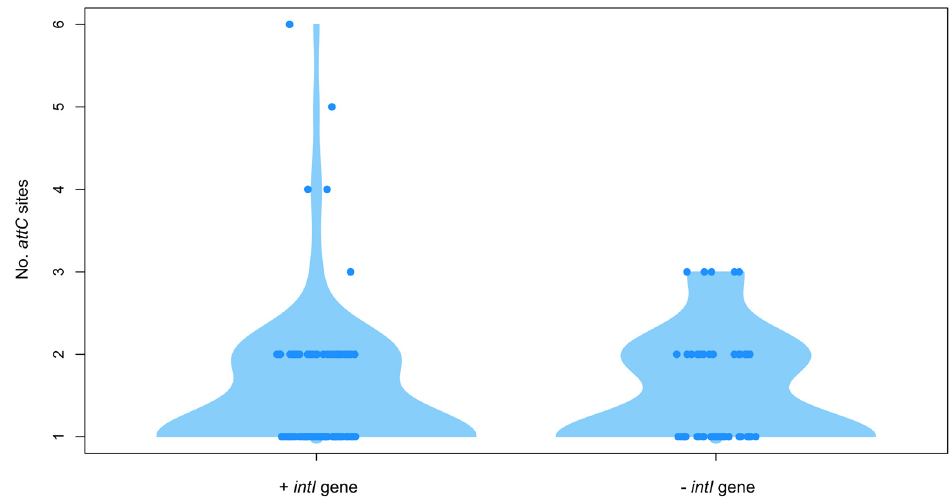
Figure 4. attC sites found in complete genomes of Shewanella spp. attC sites in CALINs and SALINs found in Shewanella spp. complete genomes with (left) and without (right) the intI integrase